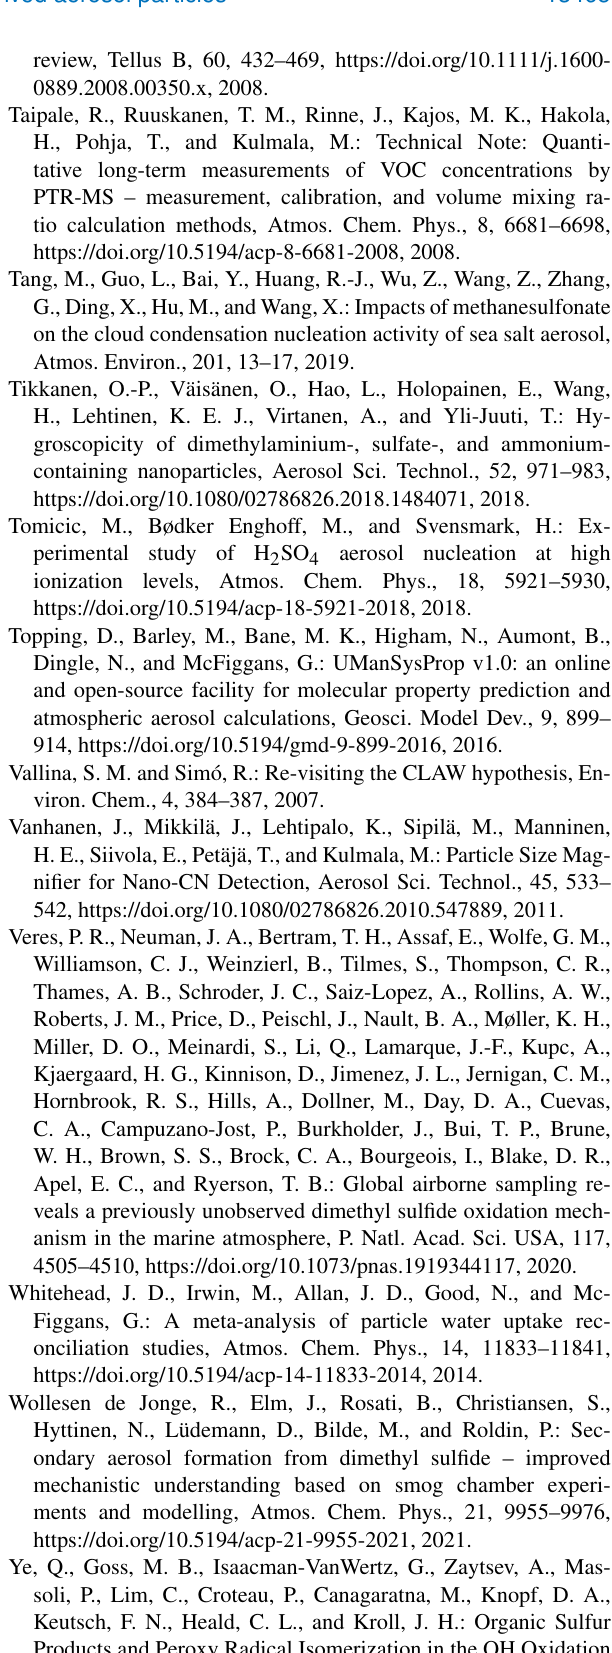
Figgans, G.: A meta-analysis of particle water uptake